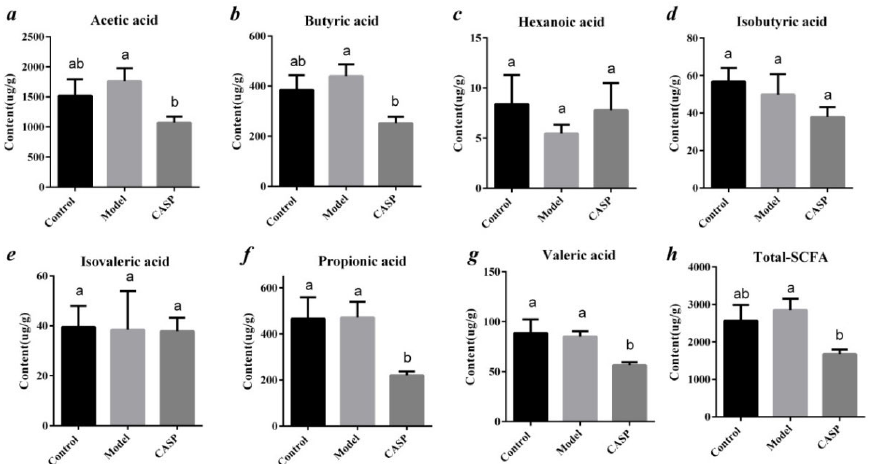
Figure 12. Content of SCFAs in chicken cecum contents in each group. Note: ( a ) The contents of acetic acid of different groups; ( b ) The contents of butyric acid of different groups; ( c ) The contents of hexanoic acid of different groups; ( d ) The contents of isobutyric acid of different groups; ( e ) The contents of isovaleric acid of different groups; ( f ) The contents of propionic acid of different groups; ( g ) The contents of valeric acid of different groups; ( h ) The contents of total ‐ SCFA of different groups. The same letter, and the different letter indicate that the inter ‐ group differences difference is non ‐ significant or significant, respectively.